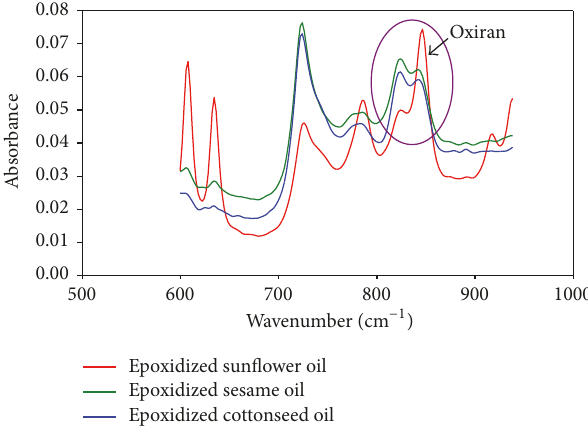
Figure 1: FTIR spectra of epoxidized sunflower, sesame, and cot- tonseed